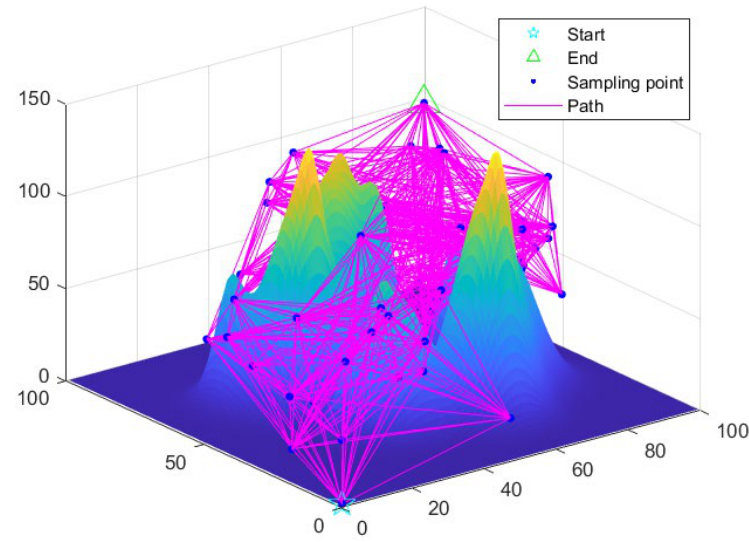
Figure 7. The effect of sampling space optimization.